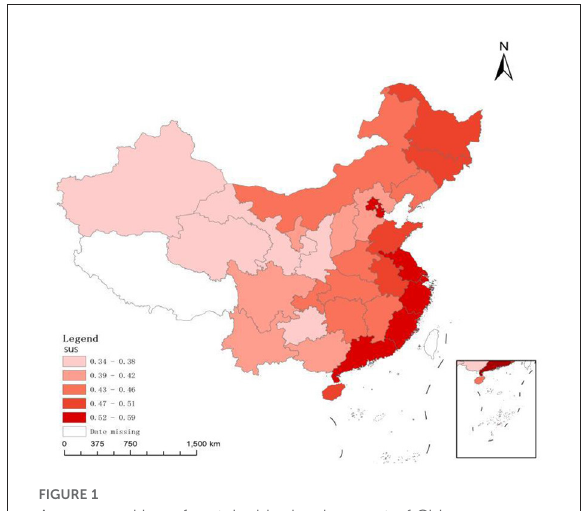
FIGURE1 Average ranking of sustainable development of Chinese provinces a . a The Drawing Review number is GS(2019)1822. And the source is http://bzdt.ch.mnr.gov.cn/download.html?